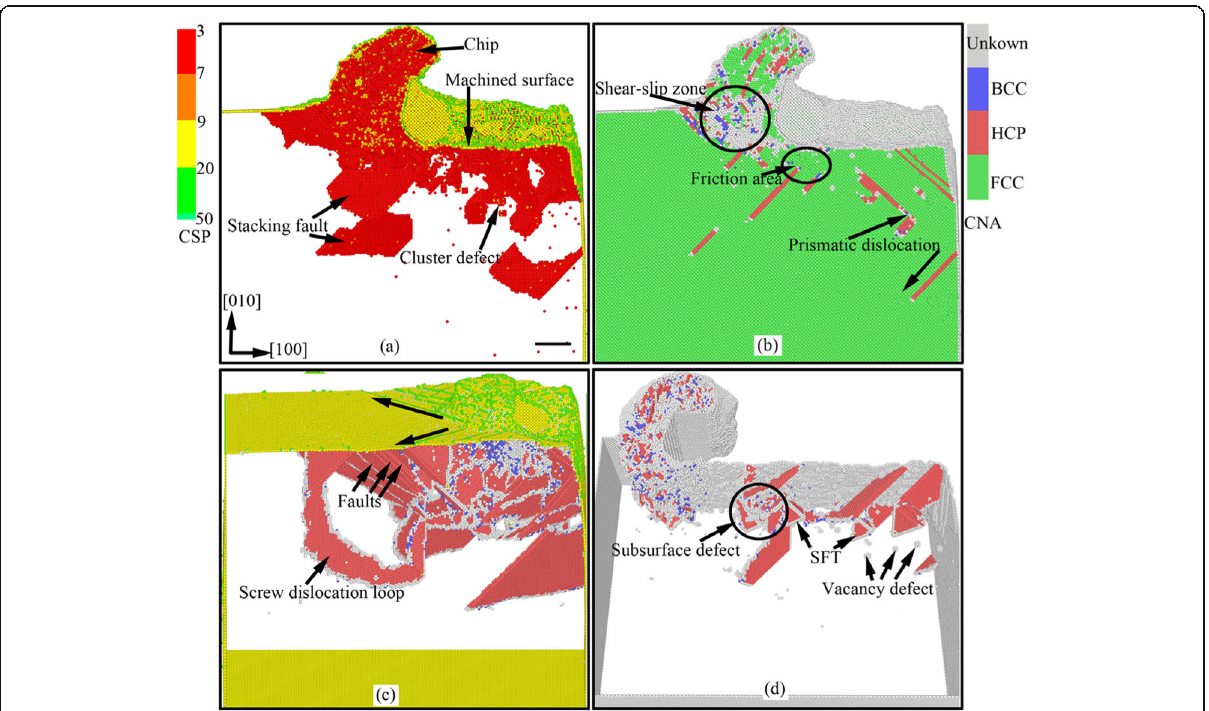
Fig. 2 Instant views of the subsurface defect evolution during nano-cutting process of single crystal copper (Color online, scale bar 5 nm). The cutting distances of a , b , c , and d respectively are 18 nm, 18 nm, 6 nm, and 32